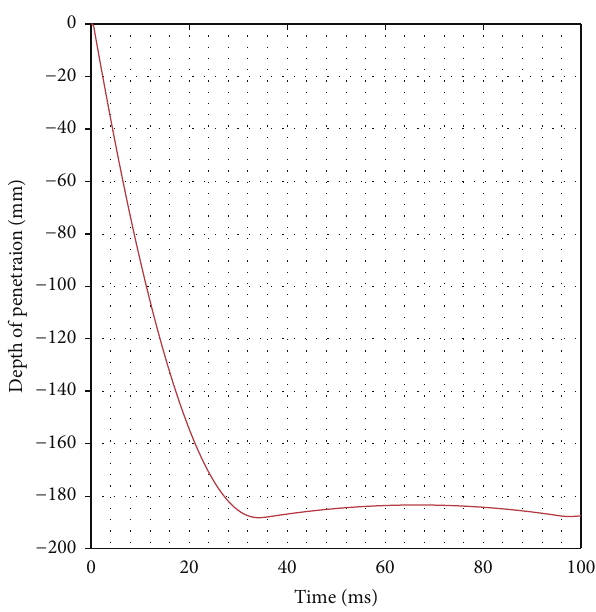
Figure 10: Missile depth of penetration (simulation results).